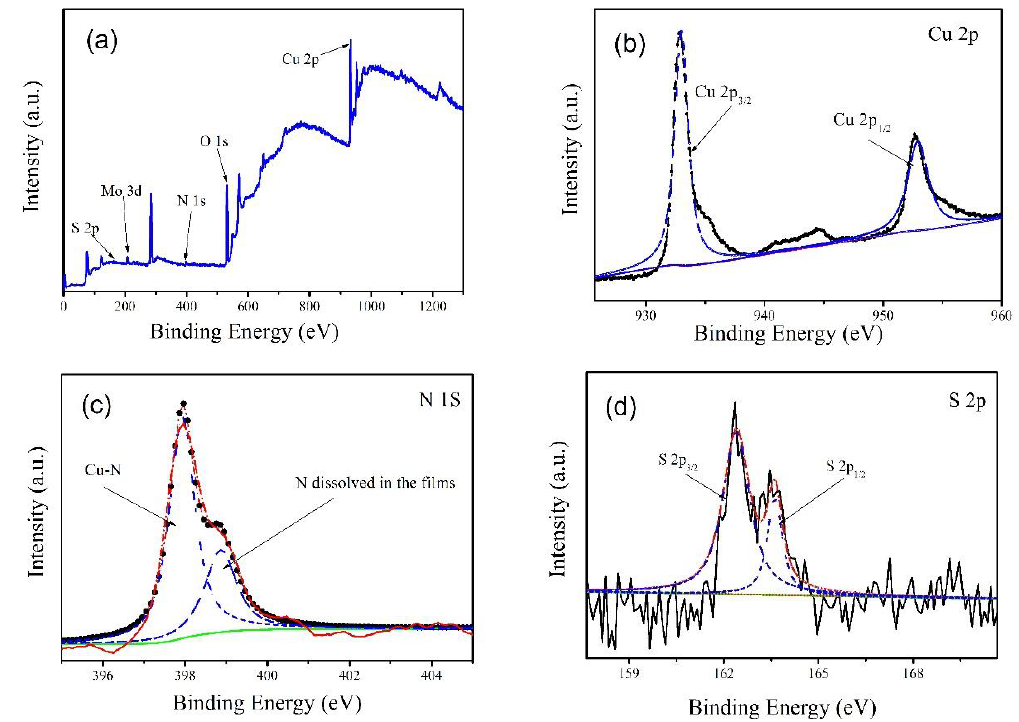
Figure 3. XPS diagram of Cu 3 N/MoS 2 composite films: ( a ) total spectrum, ( b ) Cu 2 p peak fitting, ( c ) N 1 s peak fitting, and ( d ) S 2 p peak fitting. 1 s peak fitting, and ( d ) S 2 p peak